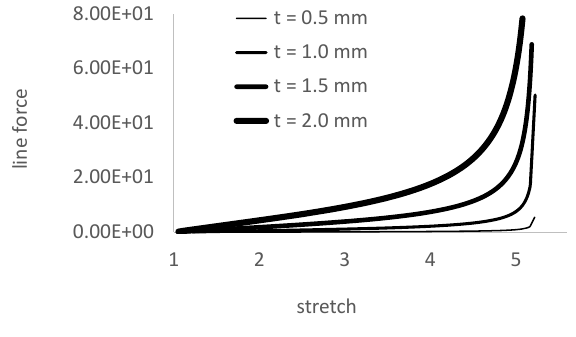
phing action for the various corrugation amplitudes indi- cated in the figure legend. The distribution of the maxi- mum bending curvatures is directly related to the depen- dence of shape curvature on corrugation amplitude, see Figure 3. The dotted line in Figure 11 indicates the curva- ture that leads to a maximum bending strain of ε ( z = ± t /2) = ∓ 0.5%. Obviously, bending strain scales linearly with laminate thickness so that thinner laminates suffer less material straining during morphing action, so that they endure higher